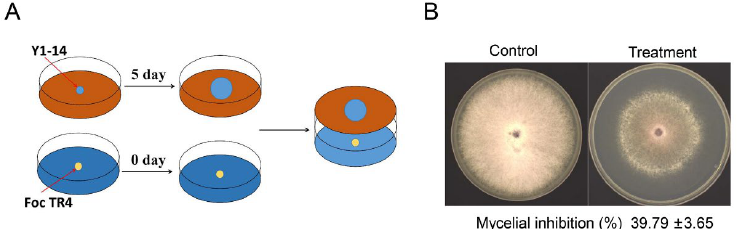
Figure 4. Antifungal activity of VOCs produced by Streptomyces sp. Y1-14 against Foc TR4. ( A ) Dou- ble plate assay was used to evaluate the antagonistic activity of Streptomyces sp. Y1-14. The blue